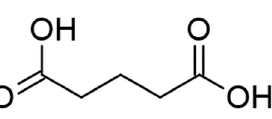
Figure 1. Molecular structure of glutaric